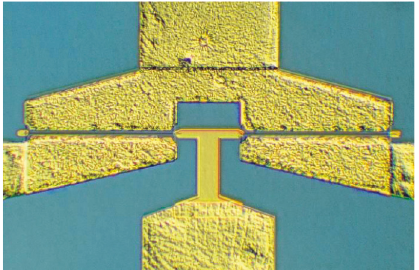
Figure 3: Construction of X-band AlGaN/GaN